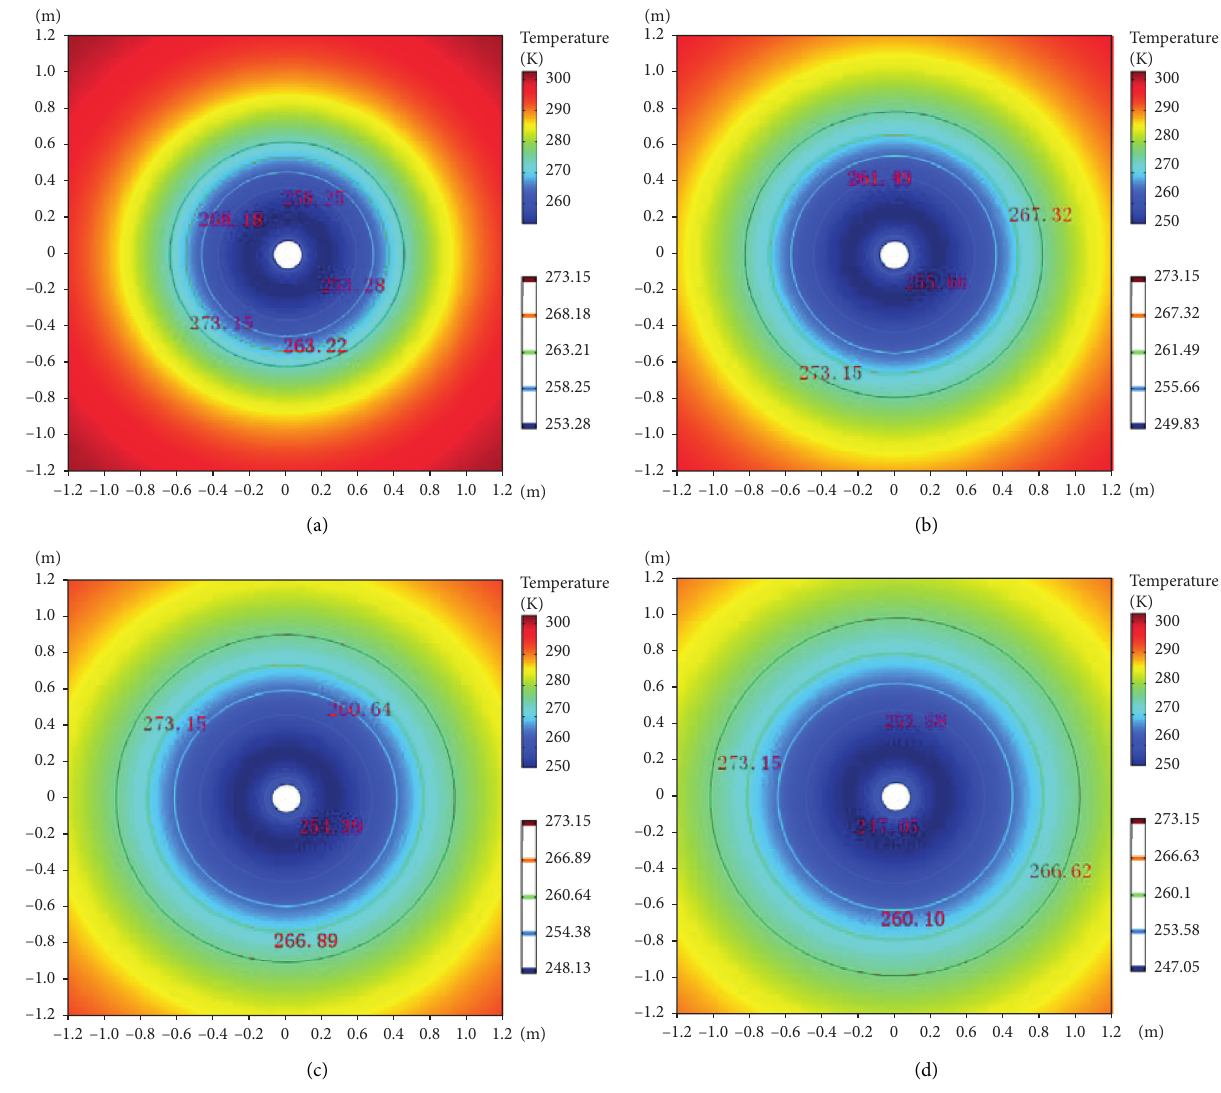
Figure 8: Temperature contour of coal seam around the injection hole at different freezing times: (a) 5d, (b) 10d, (c) 15d, and (d) 20d.